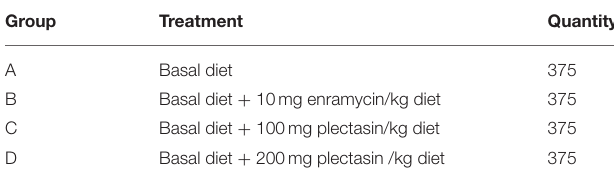
TABLE 1 | The grouping of experiment. Group